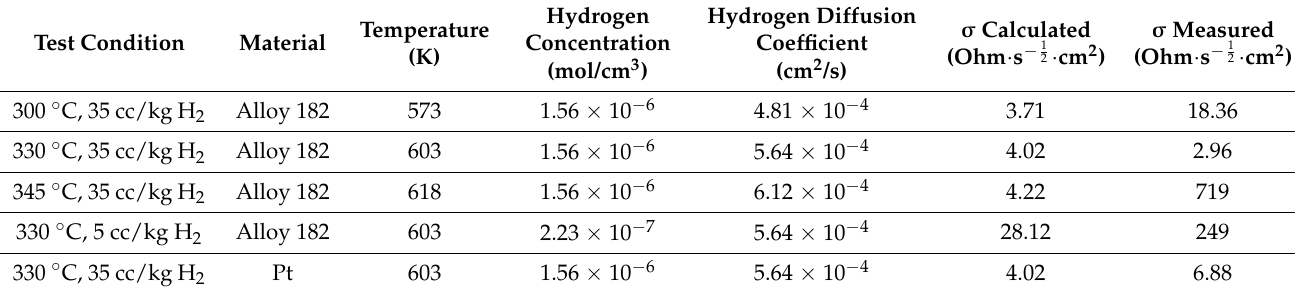
Table 5. Comparison of the calculated and measured Warburg